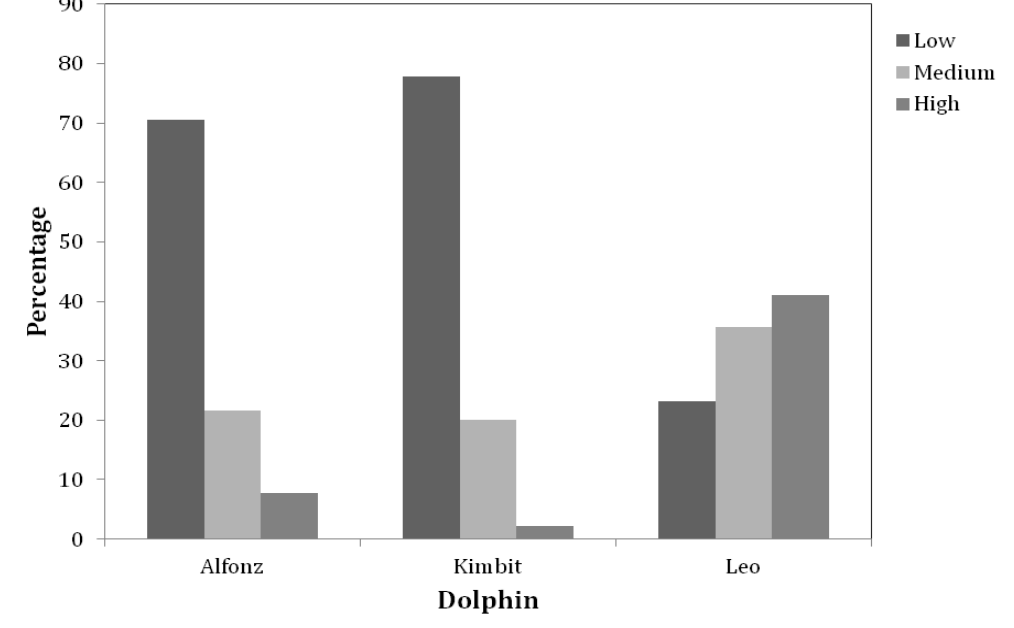
Figure 5 . Percentage of low, medium, and high energy behaviors for each dolphin at the beginning of a